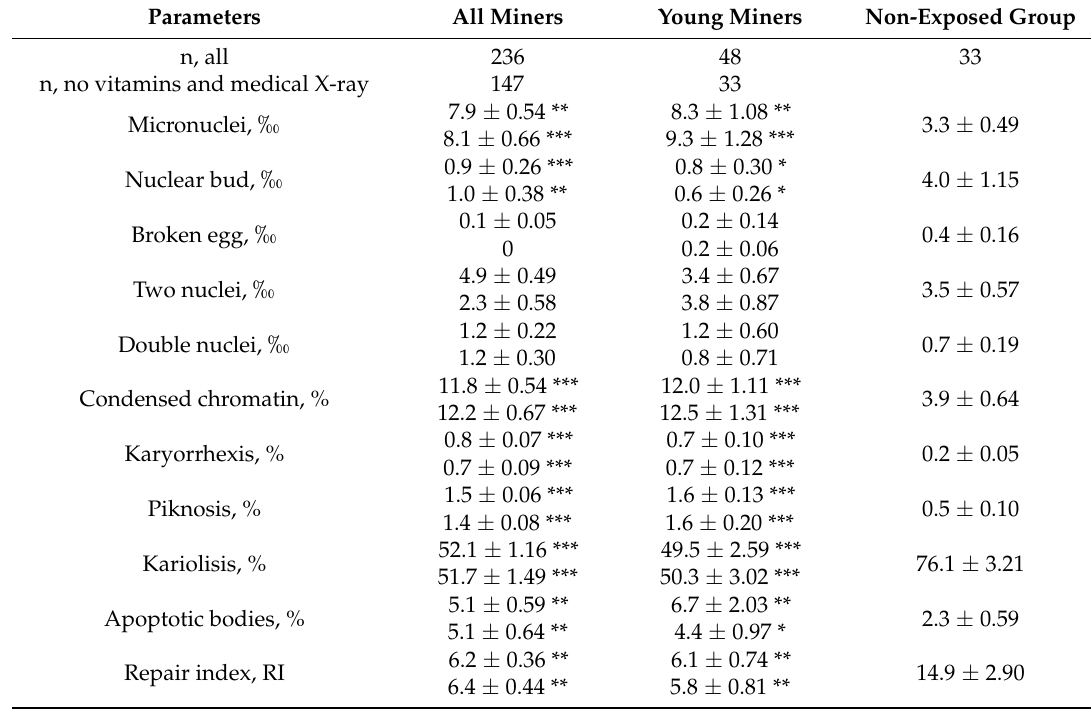
Table 2. Frequencies of micronucleus and other nuclear anomalies in exfoliated buccal epithelial cells. Parameters All Miners Young Miners Non-Exposed Group n, all n, no vitamins and medical X-ray